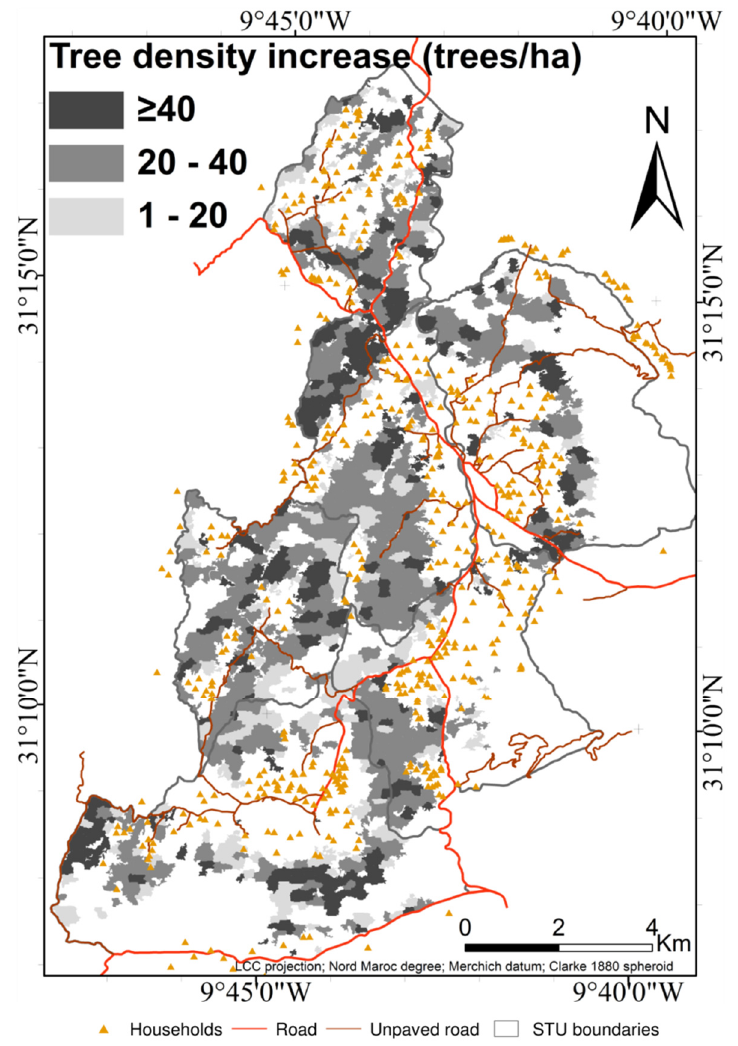
Figure 11. Simulated map of tree density change for scenario PPP after 30